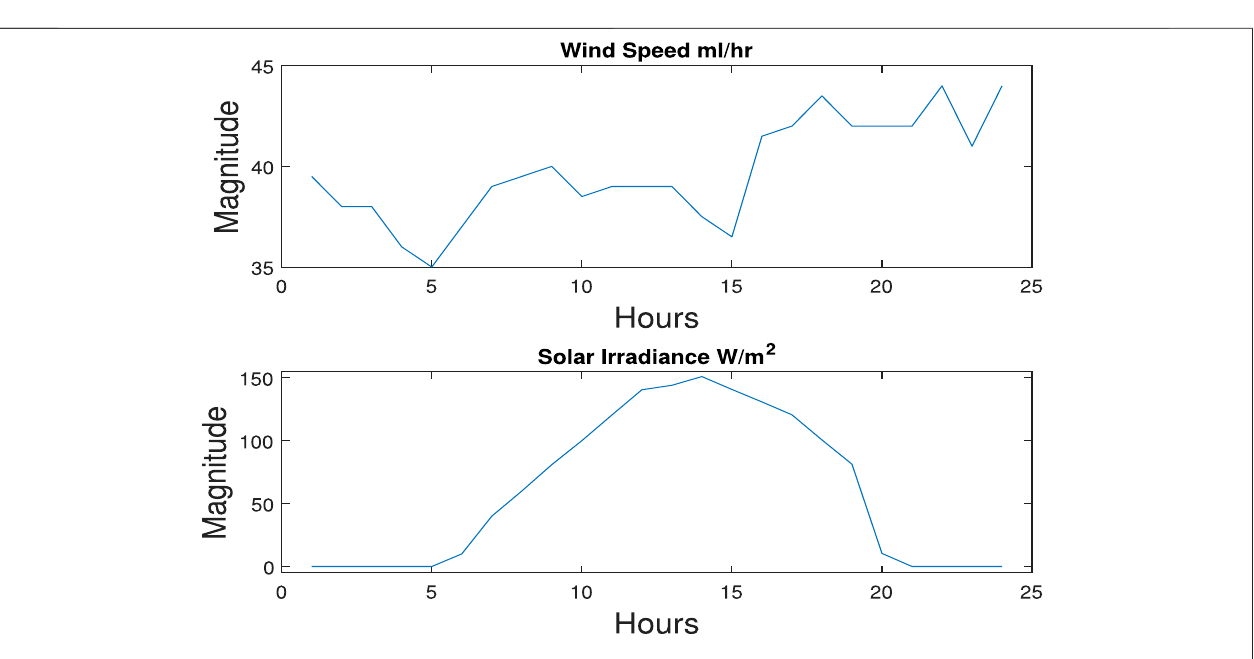
FIGURE 6 | Wind and solar data in 1D plots.